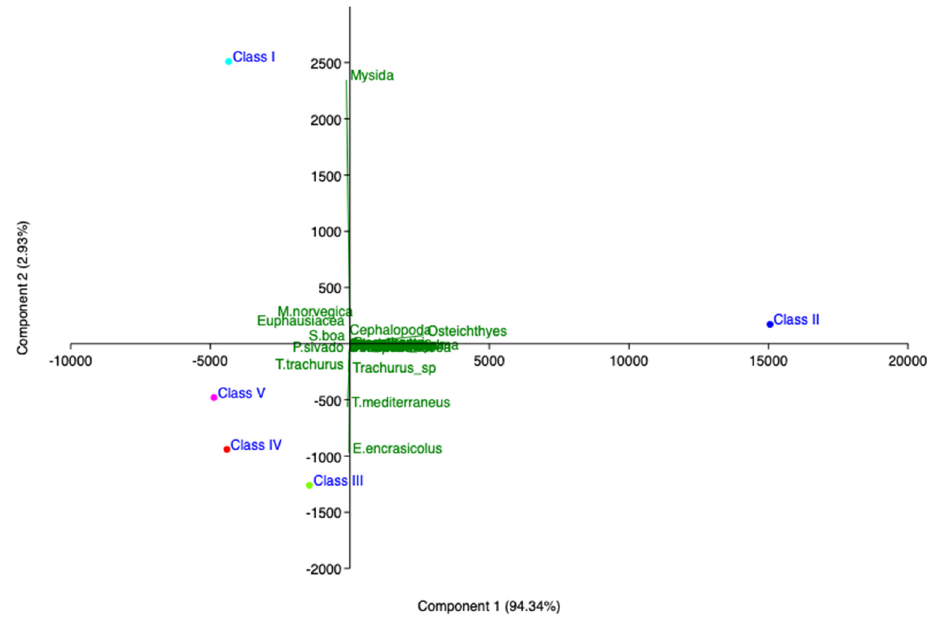
Figure 10. Principal component analysis (PCA) of hake diet in southern and central Tyrrhenian Sea (2020). Table 8. Results of the SIMPER analysis conducted between European hake trophic groups from 2020. The average similarity between cluster groups is reported. The percentage and cumulative contribution of typifying species within-group similarity of the identified hake trophic groups is shown. The table shows results obtained for the trophic clusters B (including size Classes II and III) and C (including size Classes IV and V). Trophic cluster A = less than 2 size groups.